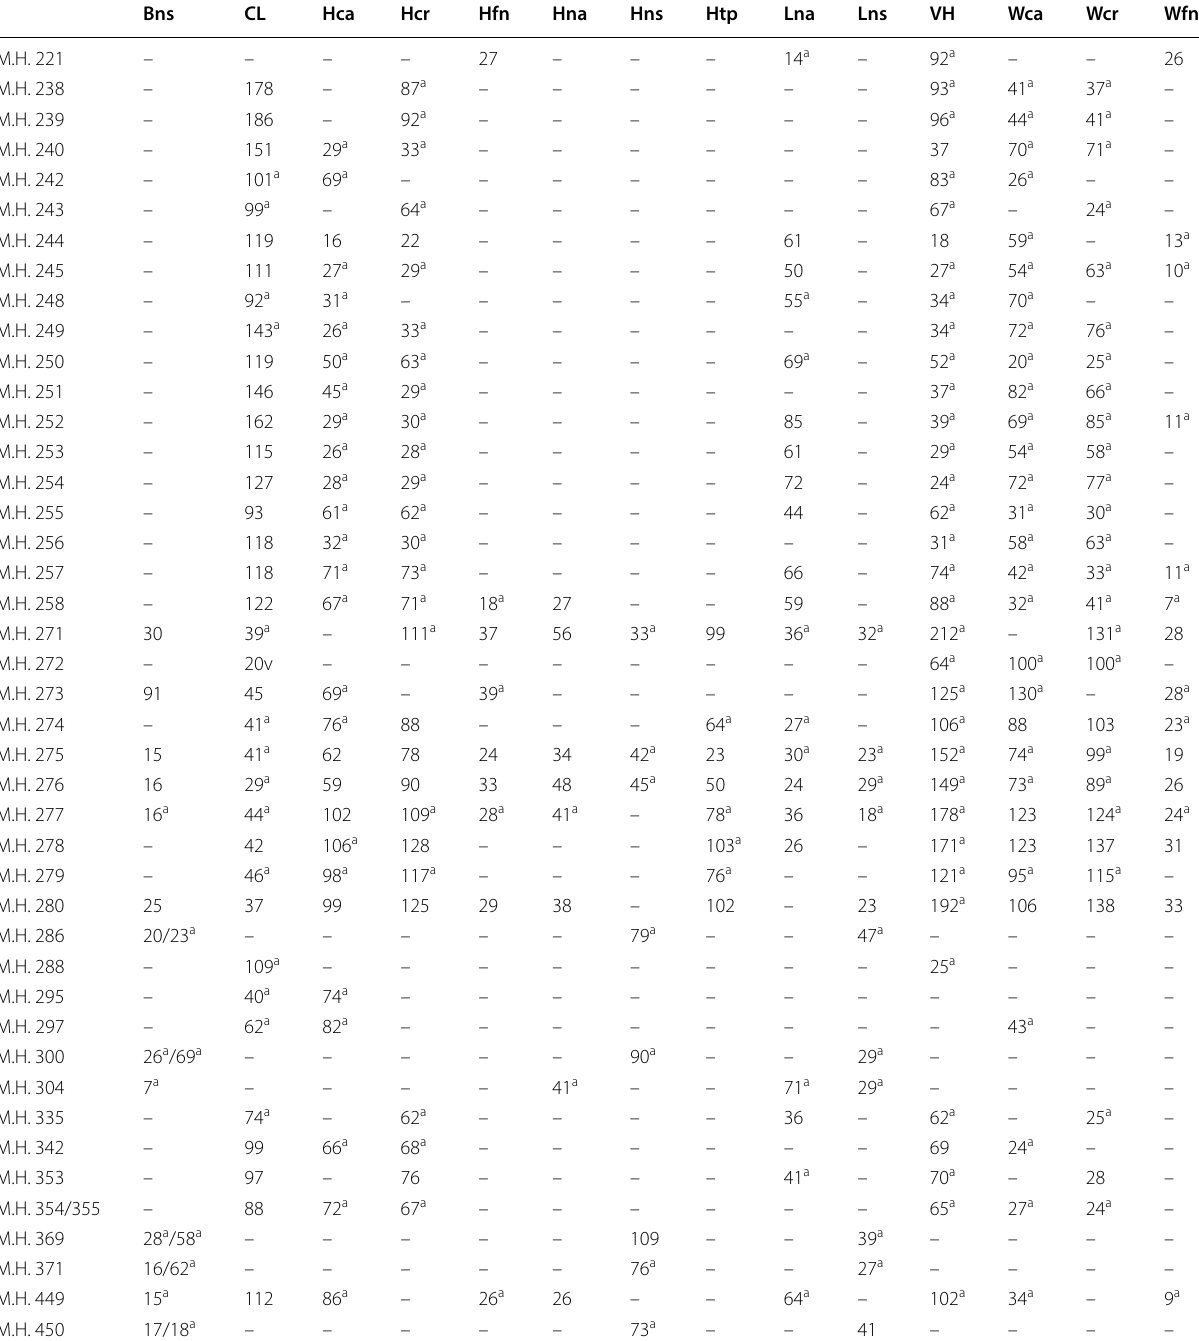
Table 5 Measurements of bones of A. greppini, from Moutier, Switzerland: Caudal